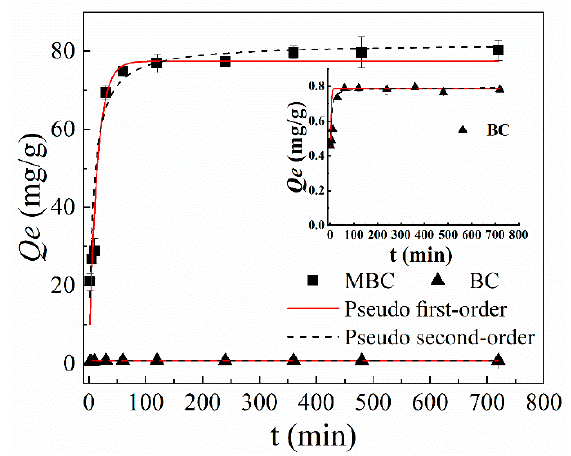
Figure 4. Sorption kinetics of As(V).